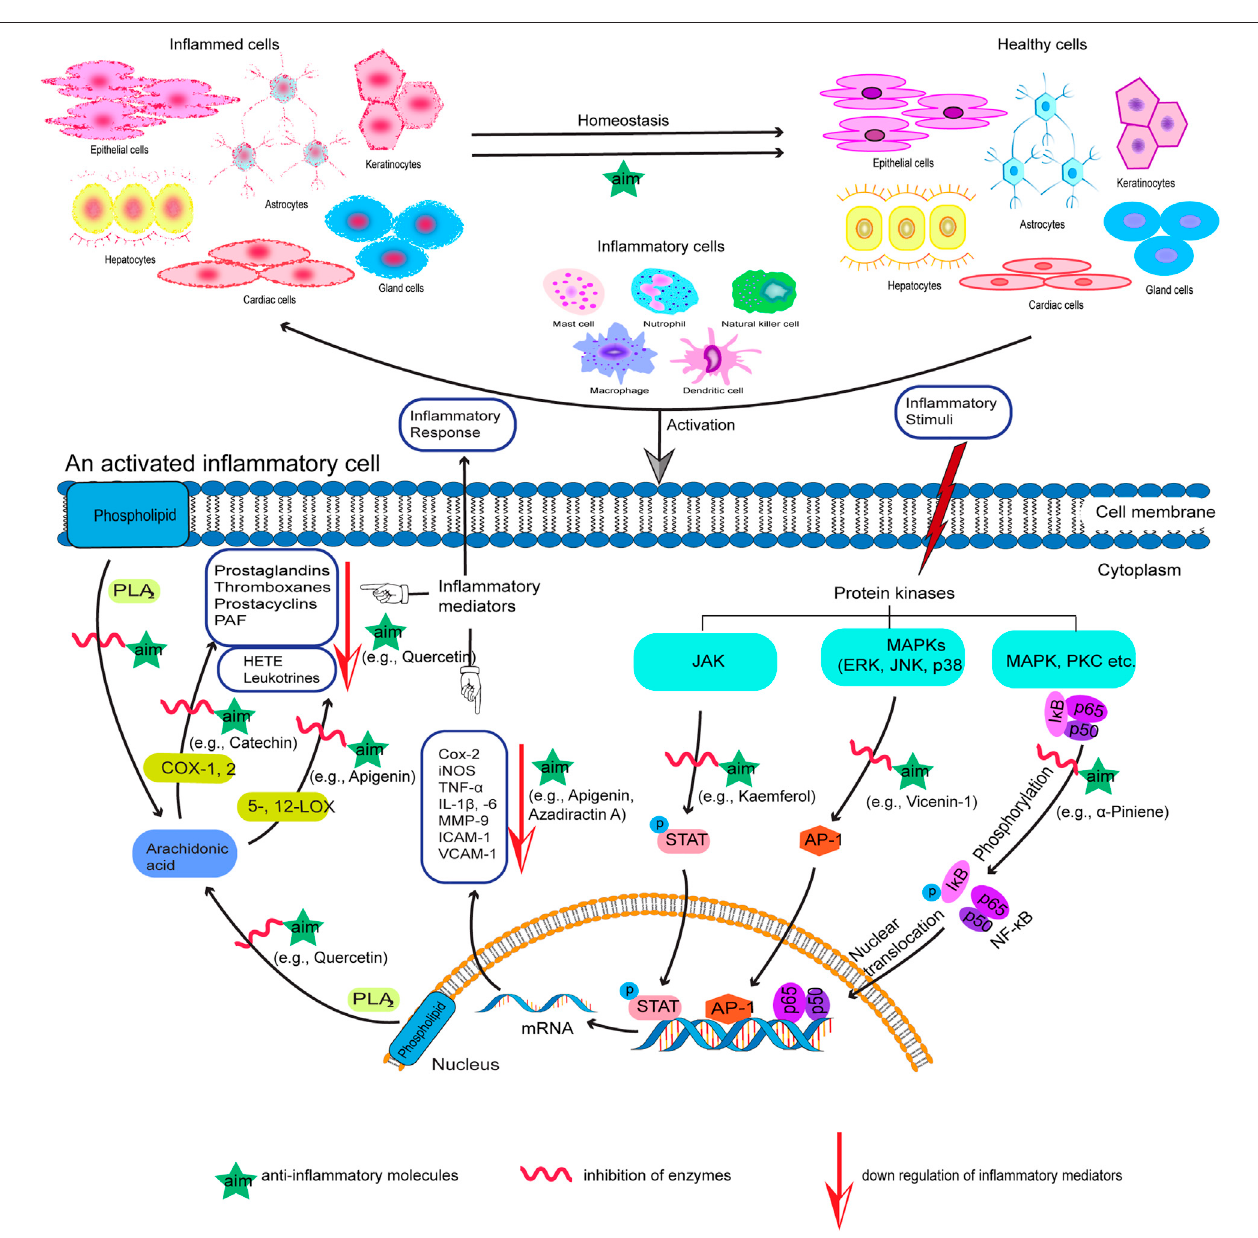
FIGURE 1 | Proposed action mechanism of anti-in fl ammatory molecules (aim) of plant origin with examples. The speci fi c pathways shown represent only a few of the plenty of diverse pathways involved in the in fl ammatory process.